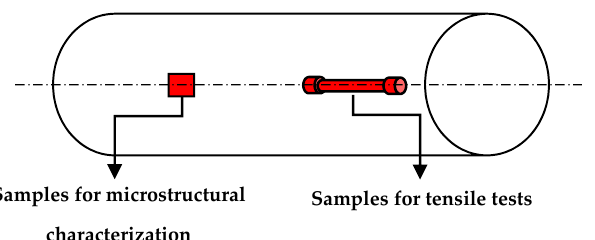
Figure 1. Location and orientation of samples for microstructural characterization and tensile tests.